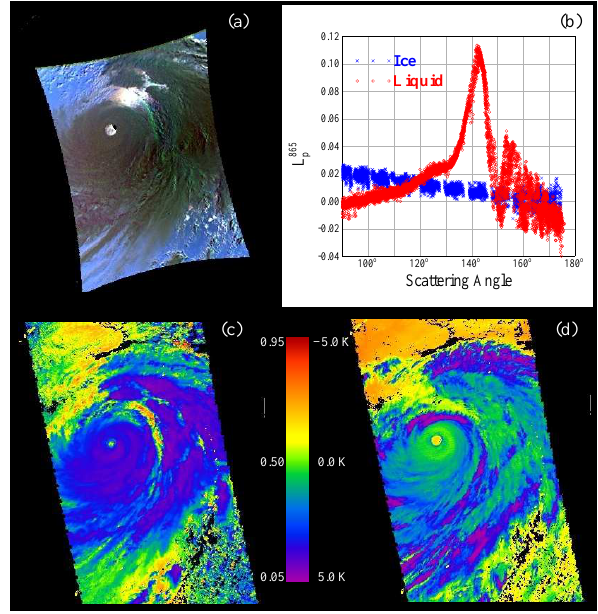
Fig. 2. Illustration over typhoon Nabi of the 3 metrics used for phase determination: (a) false color composite from 490, 670 and 865nm polarized reflectance for one instantaneous POLDER field of view, (b) typical multi-angular polarized reflectance signature (from POLDER) of liquid (red) and ice (blue) clouds, (c) ratio of shortwave infrared to visible MODIS channel (2.1 to 0.865 microm- eter), (d) brightness temperature difference between 8.5 and 11 mi- crometer MODIS